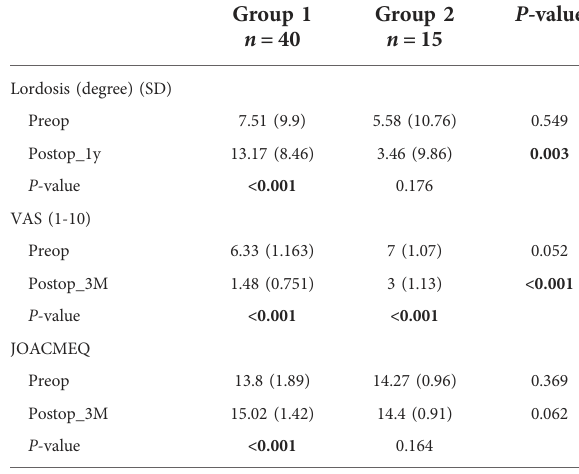
Table 1 Demographic characteristics and radiographic characteristics of 55 patients with CM due to long-segment massive OPLL undergoing cervical operation.